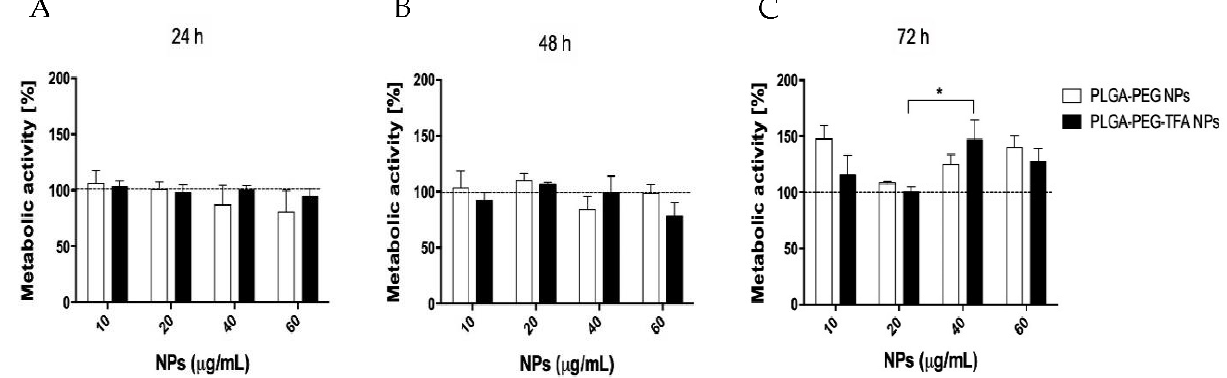
Figure 4. Cell metabolic activity assay (MTS) of the PLGA-PEG NPs and PLGA-PEG-TFA NPs loaded with NIR dye at